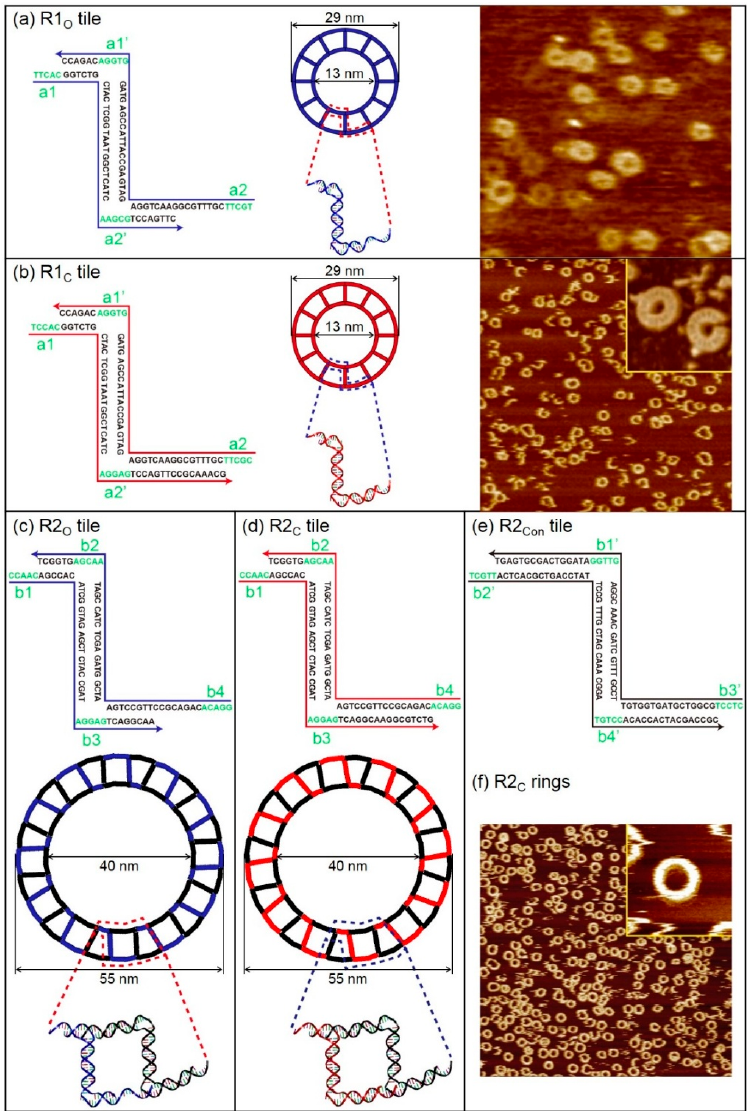
Figure 1. Schematics of finite-size DNA 2D ring structures with their unit tile sequences and their representative atomic force microscope (AFM) images. ( a ) DNA base sequence of the open-formed unit building block (referred to as an R1 O tile), schematic diagram, and corresponding AFM images of DNA 2D ring structures composed of R1 O tiles (referred to as an R1 O ring) indicated in blue. The complementary sticky end pairs are shown as a# and a#’. The outer and inner diameters of DNA rings are 29 nm and 13 nm, respectively. Here, the scan size of the image is 500 × 500 nm 2 . ( b ) DNA base sequence of the closed-formed unit building block (referred to as an R1 C tile), schematic diagram, and corresponding AFM images of DNA 2D ring structures composed of R1 C tiles (referred to as an R1 C ring) indicated in red. Scan sizes of the image and the magnified image in the inset are 1 × 1 μ m 2 and 80 × 80 nm 2 , respectively. ( c – e ) DNA base sequences of open-formed (closed-formed) and connection unit building blocks (referred to as R2 O (R2 C ) and R2 Con tiles, respectively) and schematic diagram of the DNA 2D ring structure composed of R2 O (R2 C ) and R2 Con tiles (referred to as an R2 O (R2 C ) ring) indicated in blue (red) and black, respectively. The complementary sticky end pairs are shown as b# and b#’. The outer and inner diameters of the DNA rings are 55 nm and 40 nm, respectively. ( f ) Representative AFM image of R2 C rings. Scan sizes of the image and the magnified image in the inset are 2 × 2 μ m 2 and 100 × 100 nm 2 , respectively.